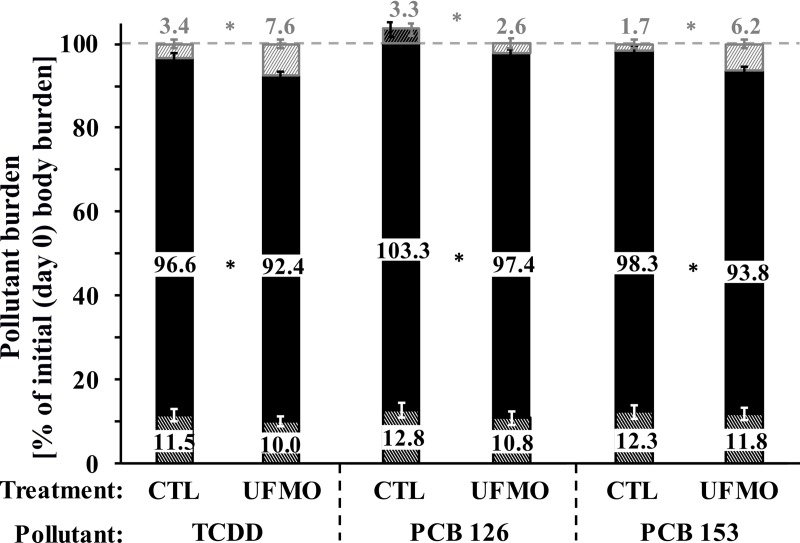
Distribution and excretion balances of pollutants between adipose tissues (sum of mesenteric, perirenal and pericaudal subcutaneous, white shaded area) and empty body (■) at slaughter, and input/outputs balance during the depuration period (sum of faecal and wool outputs–feed input from Day 0 to Day +57, grey shaded area) in ewes receiving a control well-fed and non-supplemented treatment (CTL, n = 4) or an underfed and mineral oil supplemented treatment (UFMO, n = 5).Bars represent least-squares means, error bars represent SEM and * represents a difference between treatments (P ≤ 0.05).